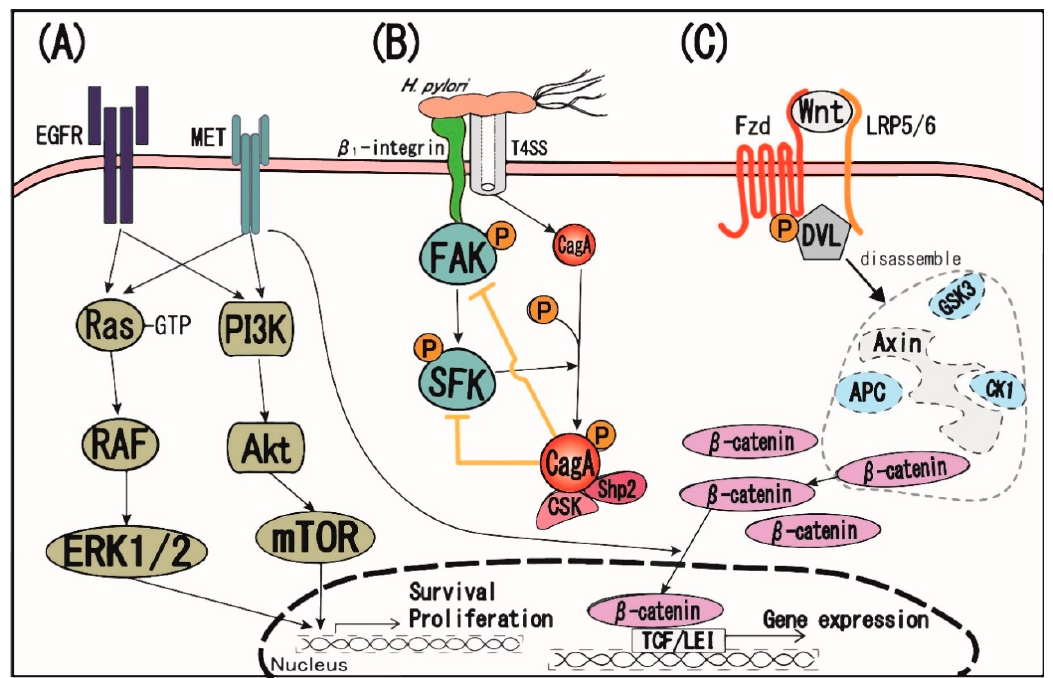
Figure 4. Other signal transduction pathways associated with H. pylori infection. ( A ) Crosstalk between the EGFR and MET pathways. ( B ) H. pylori directly binds to β 1 integrins expressed on gastric epithelial cells. Activated β 1 integrin stimulates focal adhesion kinase (FAK) and then upregulates Src family kinase (SFK) activity in the early phase of H. pylori infection. CagA delivered through the type IV secretion system into the host cytoplasm is rapidly phosphorylated by SFK. Tyrosine ‐ phosphorylated CagA inactivates FAK and SFK by interacting with Shp2 and CSK in the late phase of H. pylori infection, eventually leading to impaired cell adhesion and increased motility. ( C ) Under baseline conditions, β‐ catenin, functioning as a protein transcriptional co ‐ activator, is constantly phosphorylated by the Axin complex (also known as destructing complex). The interaction of Wnt glycoprotein ligands with Frizzled (Fzd) receptors and LRP5/6 co ‐ receptors leads to the inhibition of the degradation of β‐ catenin by destructing complex. DVL: disheveled protein, CK1: casein kinase 1, GSK3: glycogen synthase kinase 3, APC: adenomatous polyposis coli, CSK: C ‐ terminal Src kinase, mTOR: mammalian target of rapamycin.